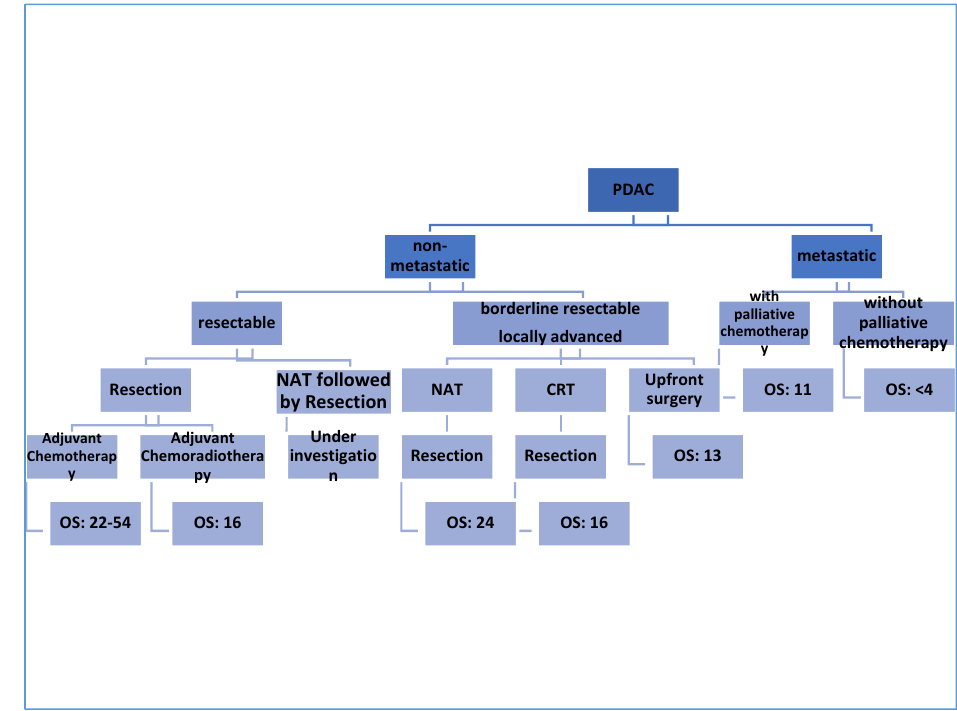
Figure 1. The outcomes of different treatment strategies in PDAC. OS: overall survival (measured in months); NAT: neoadjuvant chemotherapy.